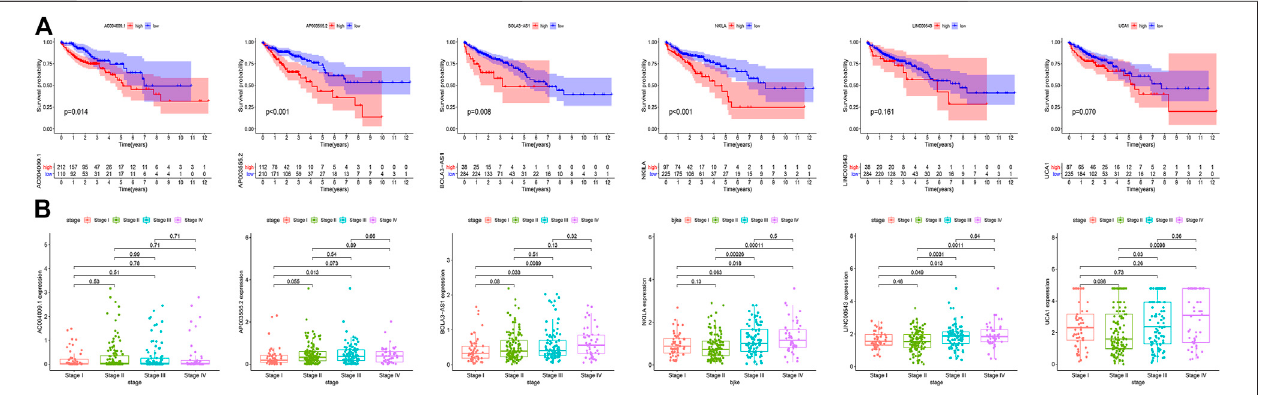
FIGURE 4 | (A) Kaplan – Meier curves of overall survival in six key DGIA lncRNAs. (B) The correlation between six key DGIA lncRNAs and pathologic